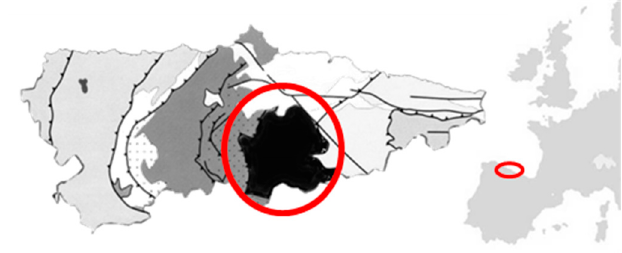
Figure 1. Location of the Asturian Central Carboniferous